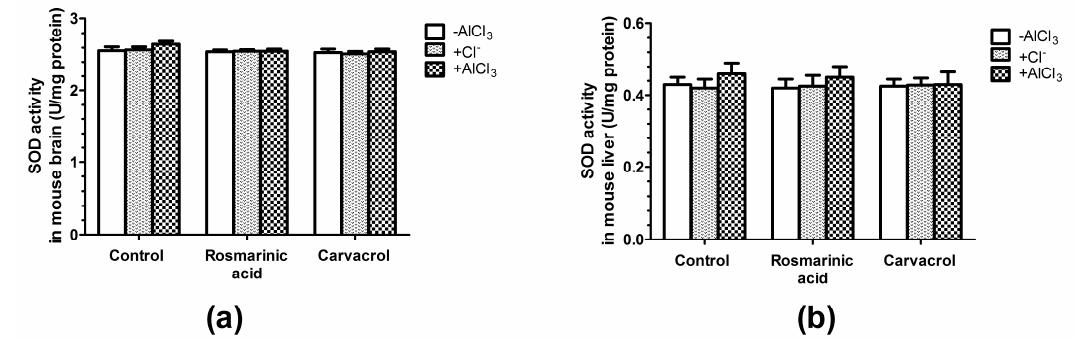
Figure 5. Influence of aluminum ions, rosmarinc acid, and carvacrol on the activity of superoxide dismutase (SOD) in mice brain ( a ) and liver ( b ) homogenates ( n = 9).